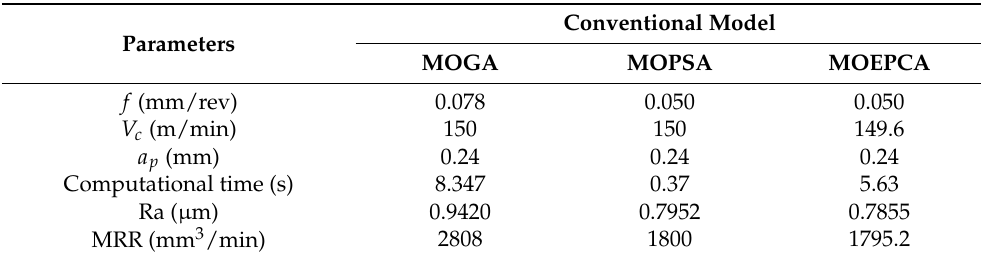
Table 7. The optimal solution results for the conventional